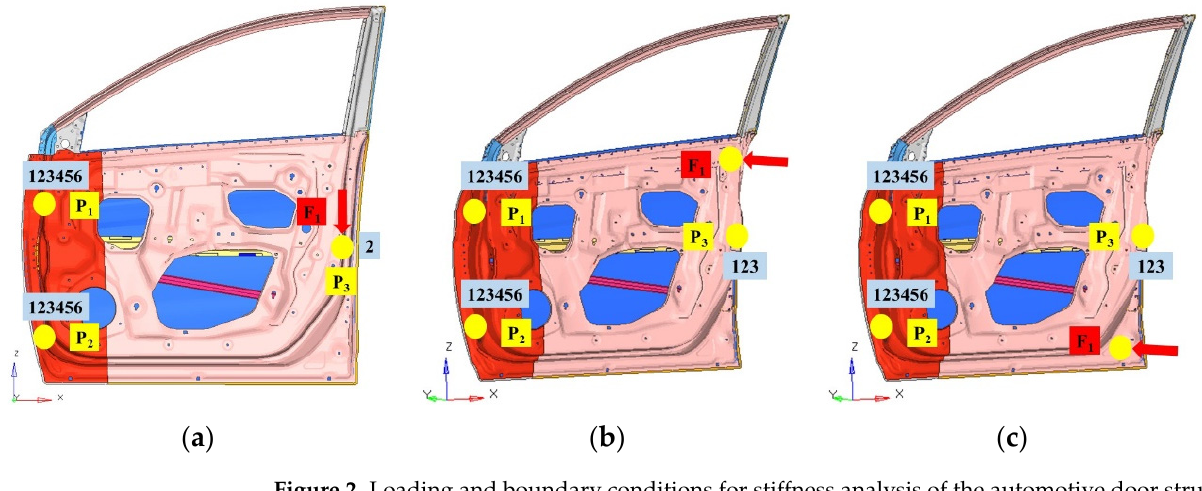
Figure 2. Loading and boundary conditions for stiffness analysis of the automotive door structure. ( a ) Vertical sag, ( b ) upper lateral, and ( c ) lower lateral.